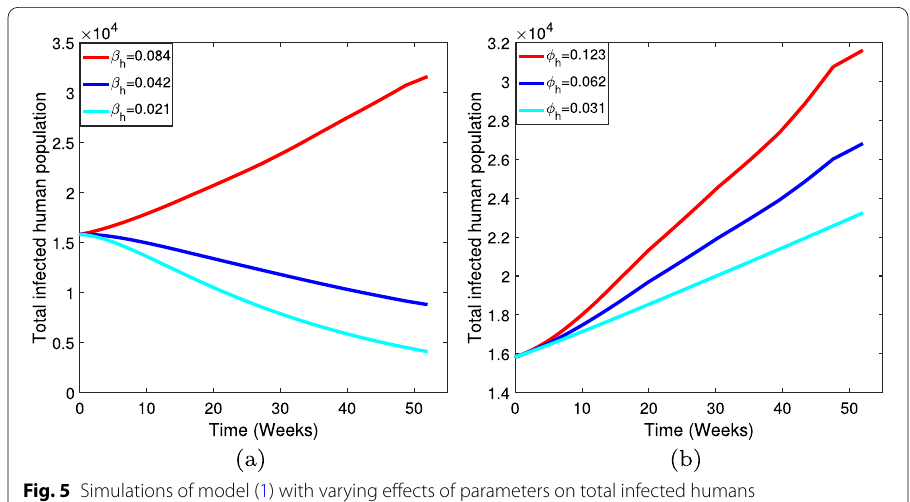
Fig. 5 Simulations of model (1) with varying effects of parameters on total infected humans population ( E h + I h ) : a transmission probability from humans to humans β h = 0.084 ( R 0 = 1.91 ) , β h = 0.042 ( R 0 = 1.25 ) , and β h = 0.021 ( R 0 = 0.92 ) ; b recovery rate of humans φ h = 0.123 ( R 0 = 1.91 ) , φ h = 0.062 ( R 0 = 1.90 ) , φ h = 0.031 ( R 0 = 1.89 ) ; Other parameter values used are as given in Table